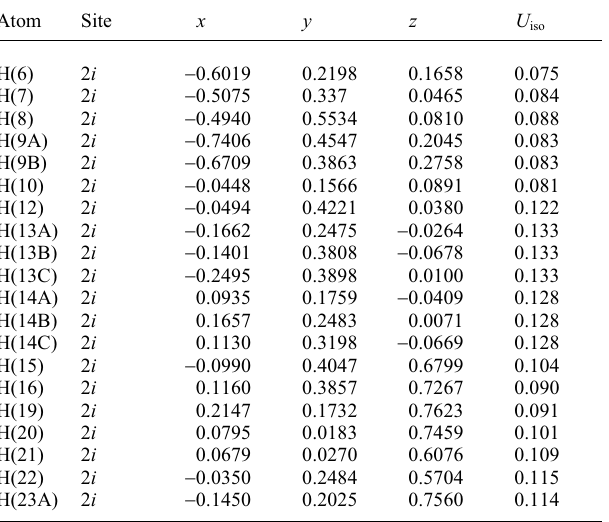
Table 3. Atomic coordinates and displacement parameters (in Å 2 )